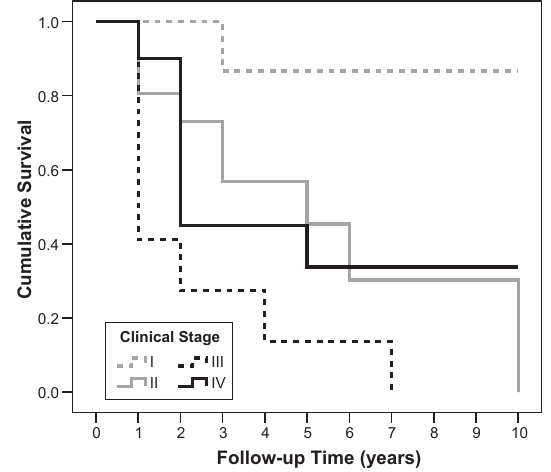
Figure 3 - Mortality and Kaplan-Meier curves with uni- variate significance determined by the log-rank test, clinical stage predictor, for subjects with DLBCL of the OC-MR, seen at the A.C. Camargo Hospital for Cancer, between January 1980 and December